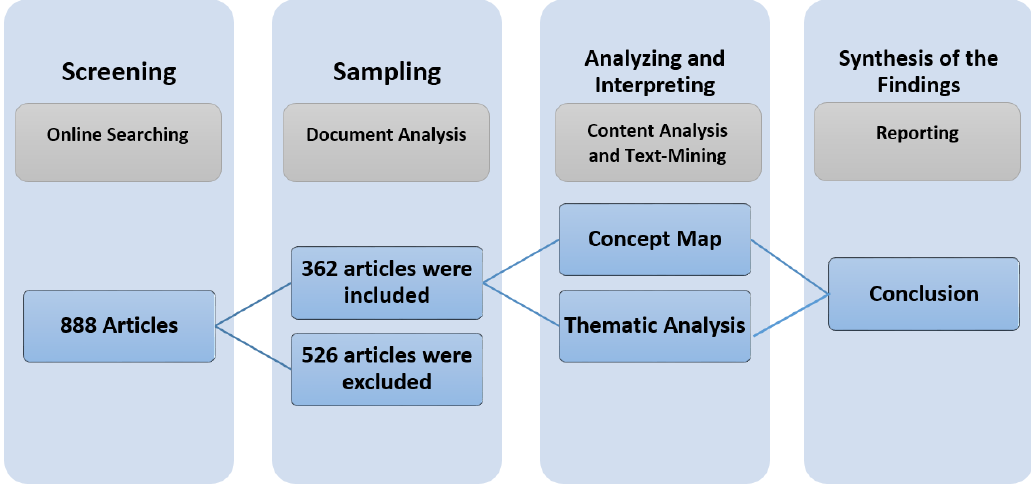
Figure 1. Phases of the research process.